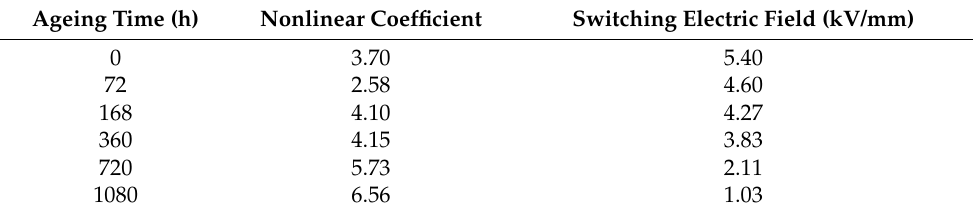
Figure 4. Relationship between current density and electric field strength of aged SiC/epoxy micro- composites under different ageing time.